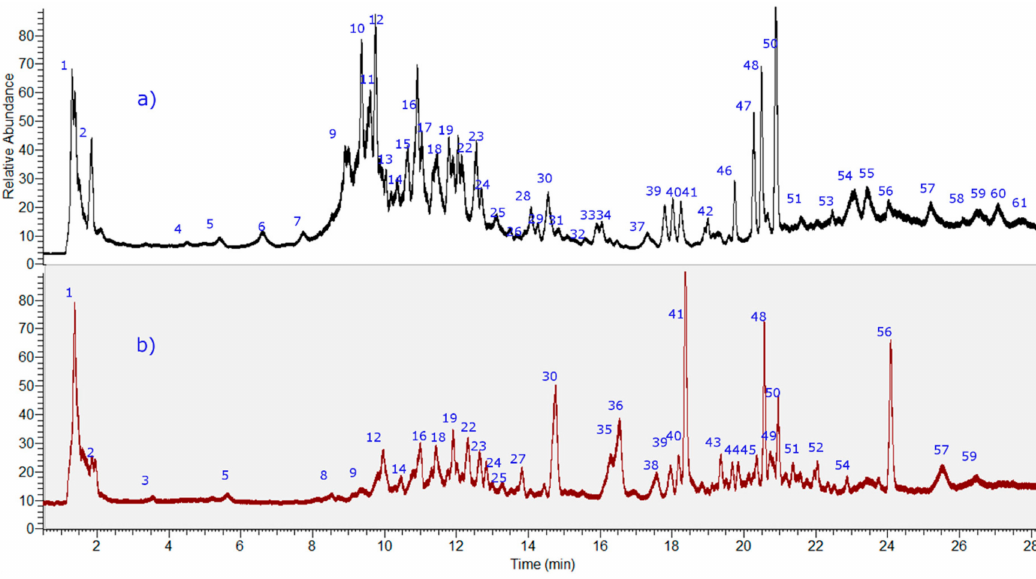
Figure2. Photodiodearray(PDA)chromatograms(UHPLC-PDA)of N.ramosissima extracts( a )methanol extract; ( b ) aqueous extract, at 280 nm.